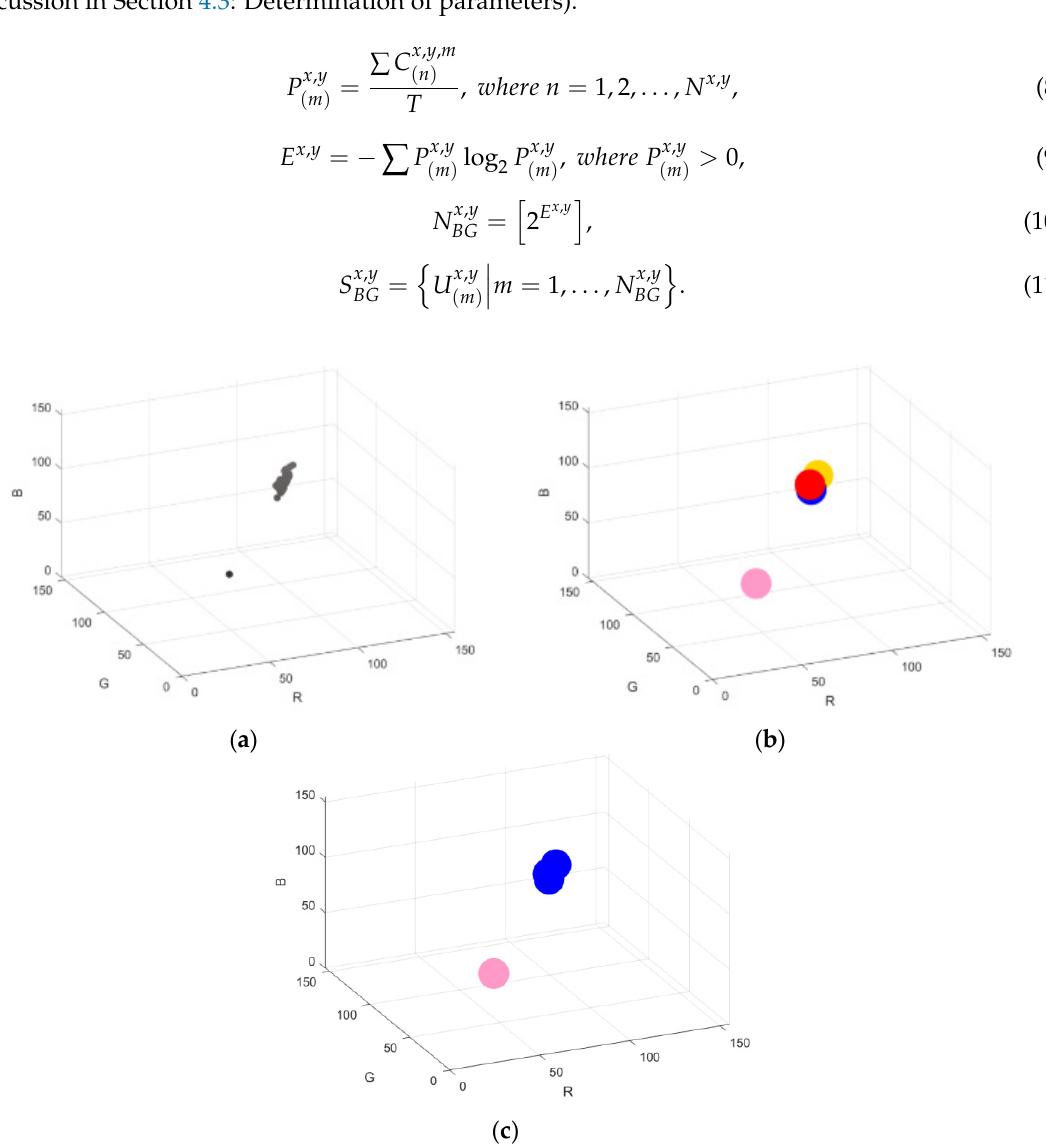
Figure 2. The process of joint category clustering. ( a ) Color distribution of the original data, ( b ) results of color classification, ( c ) results of joint category clustering.